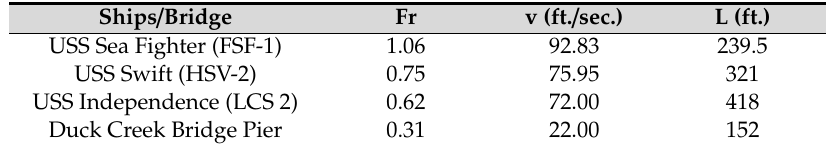
Table 3. Froude number calculation for high-speed ships and Duck Creek Bridge Pier in Las Vegas,